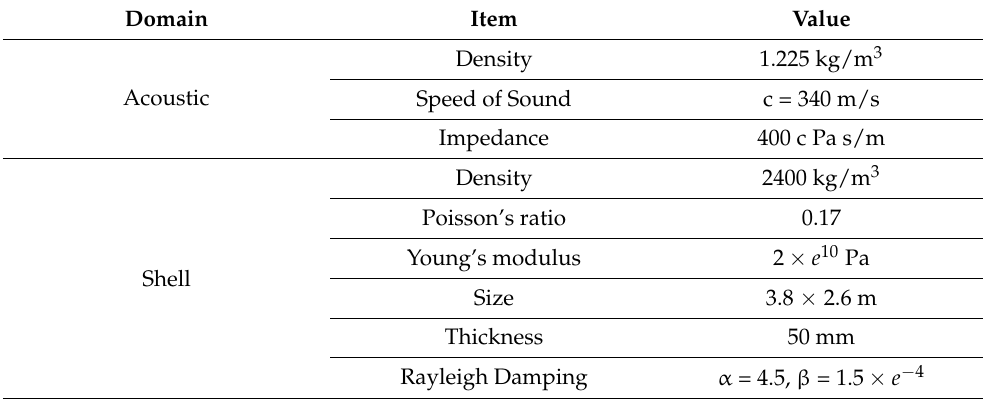
Table 1. Material property information of the modeled structure, which was necessary for FEM